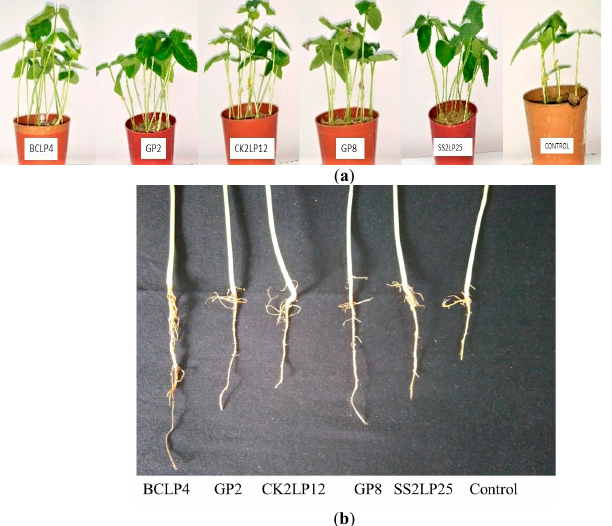
* Values in the bracket are angular transformed values. Values are the mean of four replications and each replicated value is the mean of 5 plants . α Values with different letters are significantly different at p < 0.05.